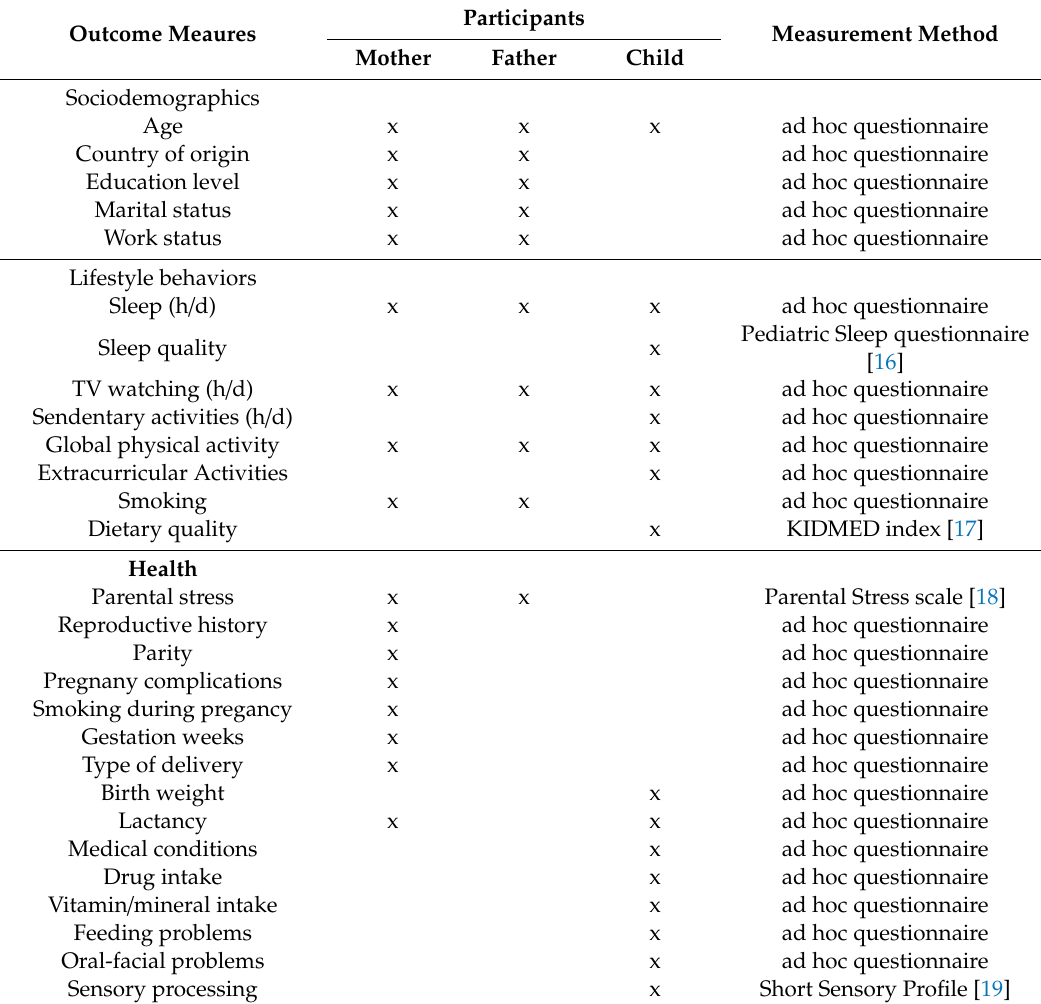
Table 1. Summary of the data collection for the InProS